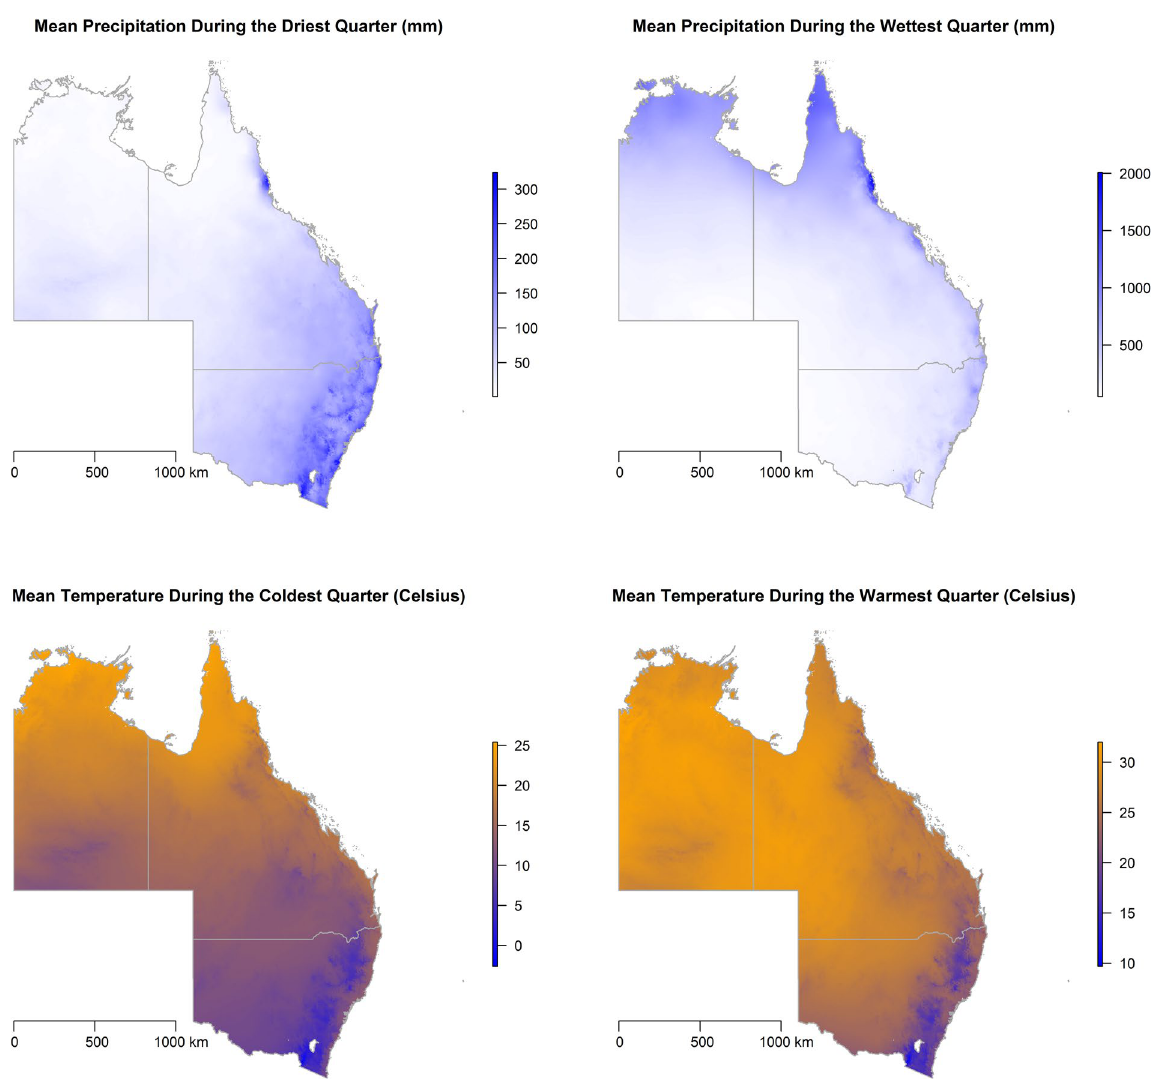
Figure 2. Climate distribution maps. The distribution of mean precipitation during the driest and wettest quarters and mean temperature during the coldest and warmest quarters. All maps created in R (v. 3.3.1) 42